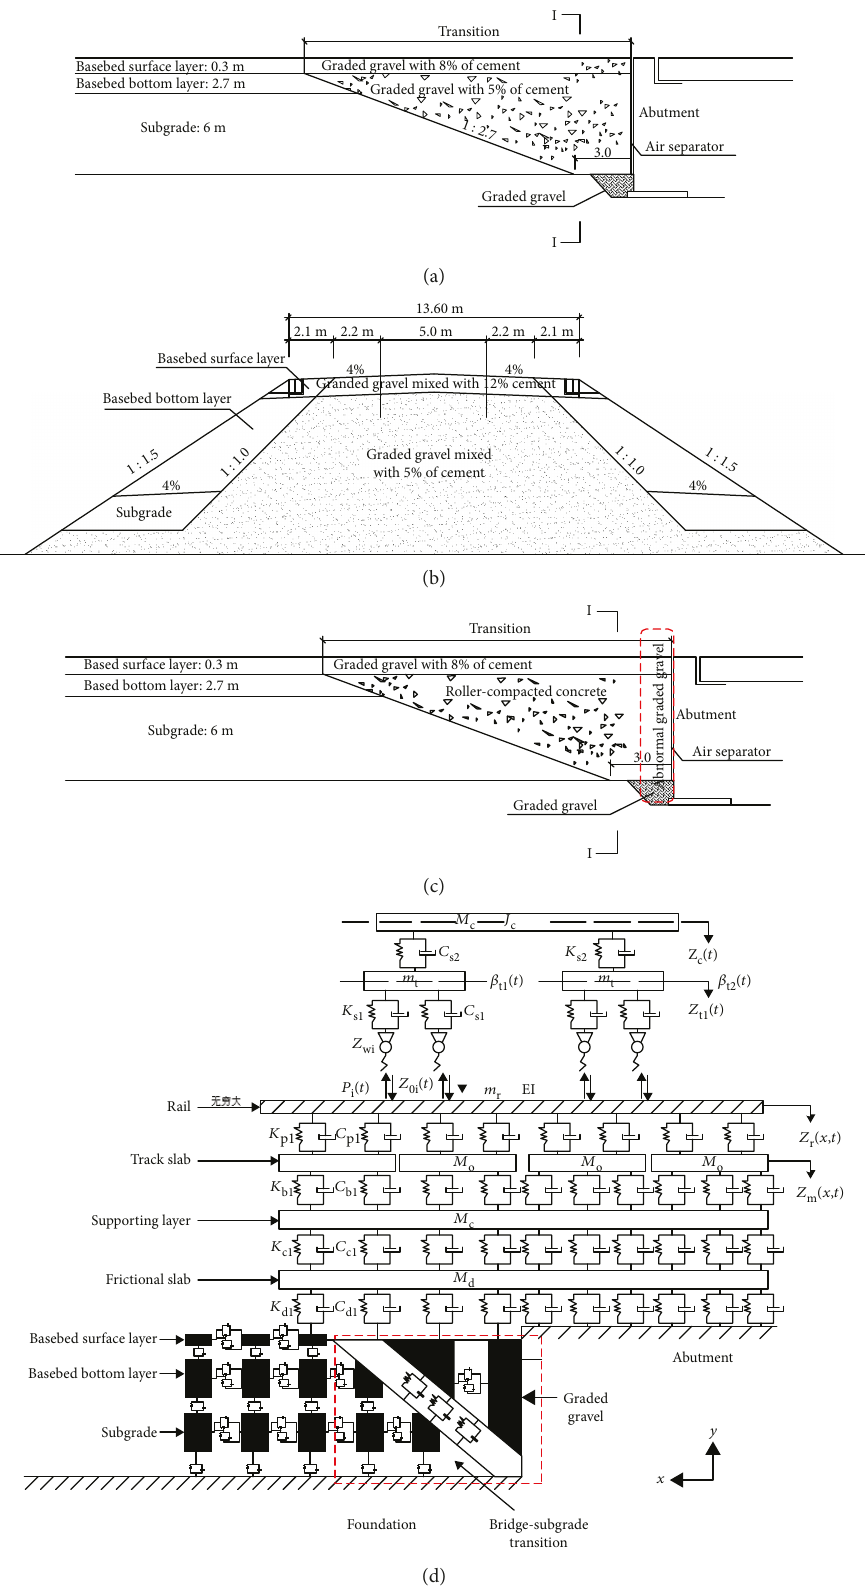
Figure 5: (a) Design diagram of bridge- (culvert) subgrade transition section. (b) I-I cross-section diagram. (c) Design diagram of the new type of bridge- (culvert) subgrade transition section. (d) Vertical dynamic analysis model of vehicle-track-subgrade coupled